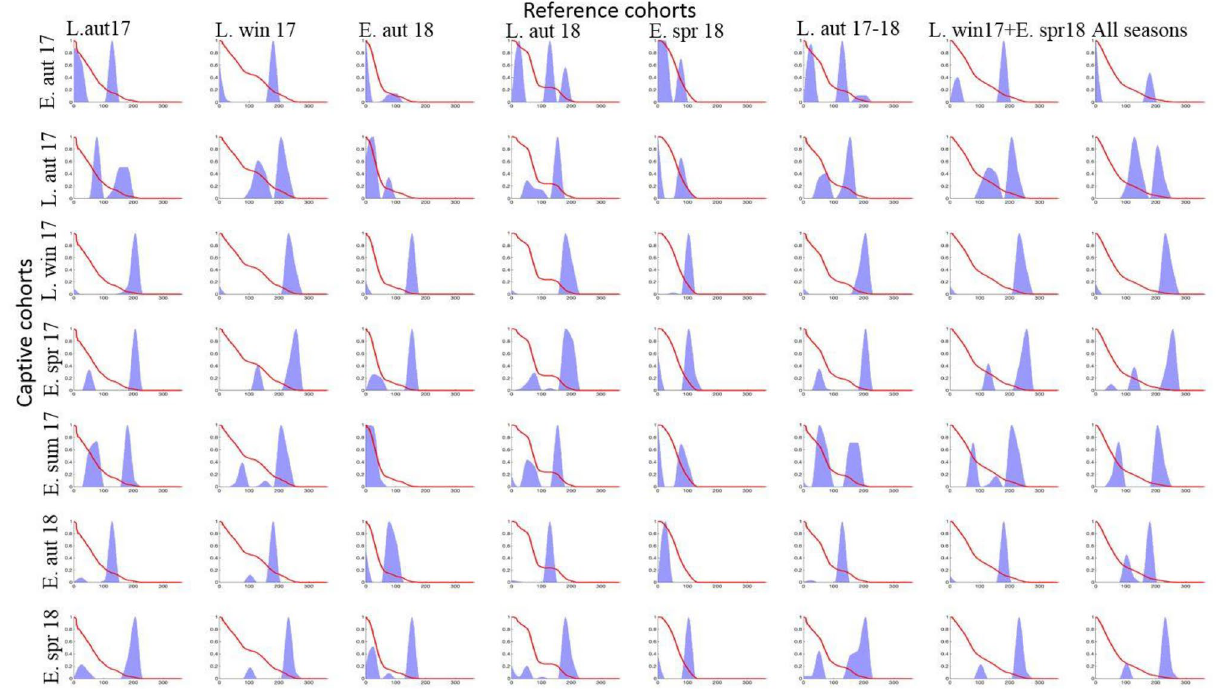
Figure 3. Probability density of age (in days) of wild Bactrocera tryoni captured during different seasons in 2017–18 from a site in subtropical Australia. Each graph is the fitted age-distribution for the season as estimated using the likelihood function with all possible combinations of reference cohorts. The red line is the survival function of the reference cohort used in the estimation of the likelihood function and the blue curves are age- distribution (L = late, E = early, aut = autumn, win = winter, spr = spring, sum = summer, 17 = 2017 and 18 =